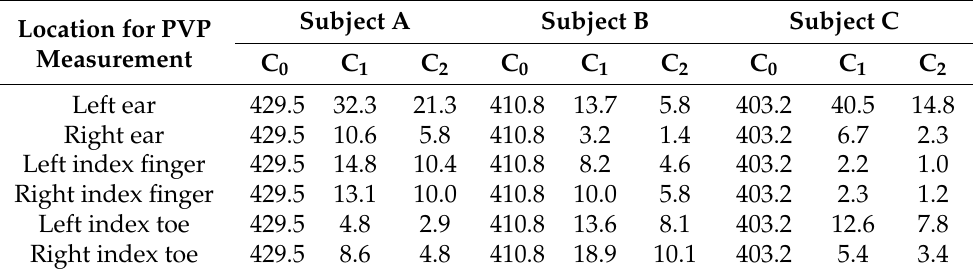
Table 2. Three coefficients ( C 0 , C 1 , and C 2 ) of discrete-time Fourier series from Subjects A and B in